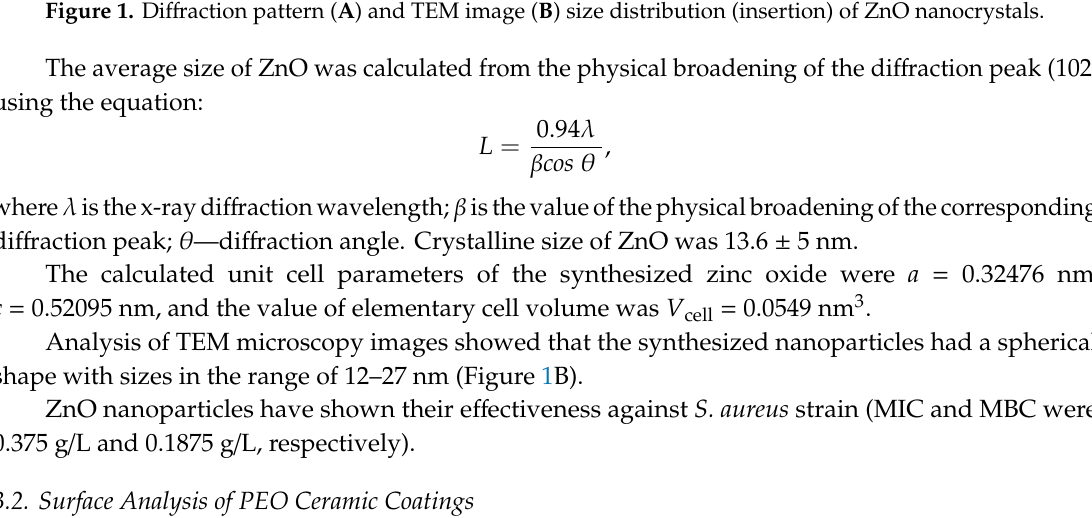
Figure 3. The pore size distribution of PEO-treated implants in Ca(H 2 PO 2 ) 2 electrolyte bath (upper row) and with ZnO NPs (low row).